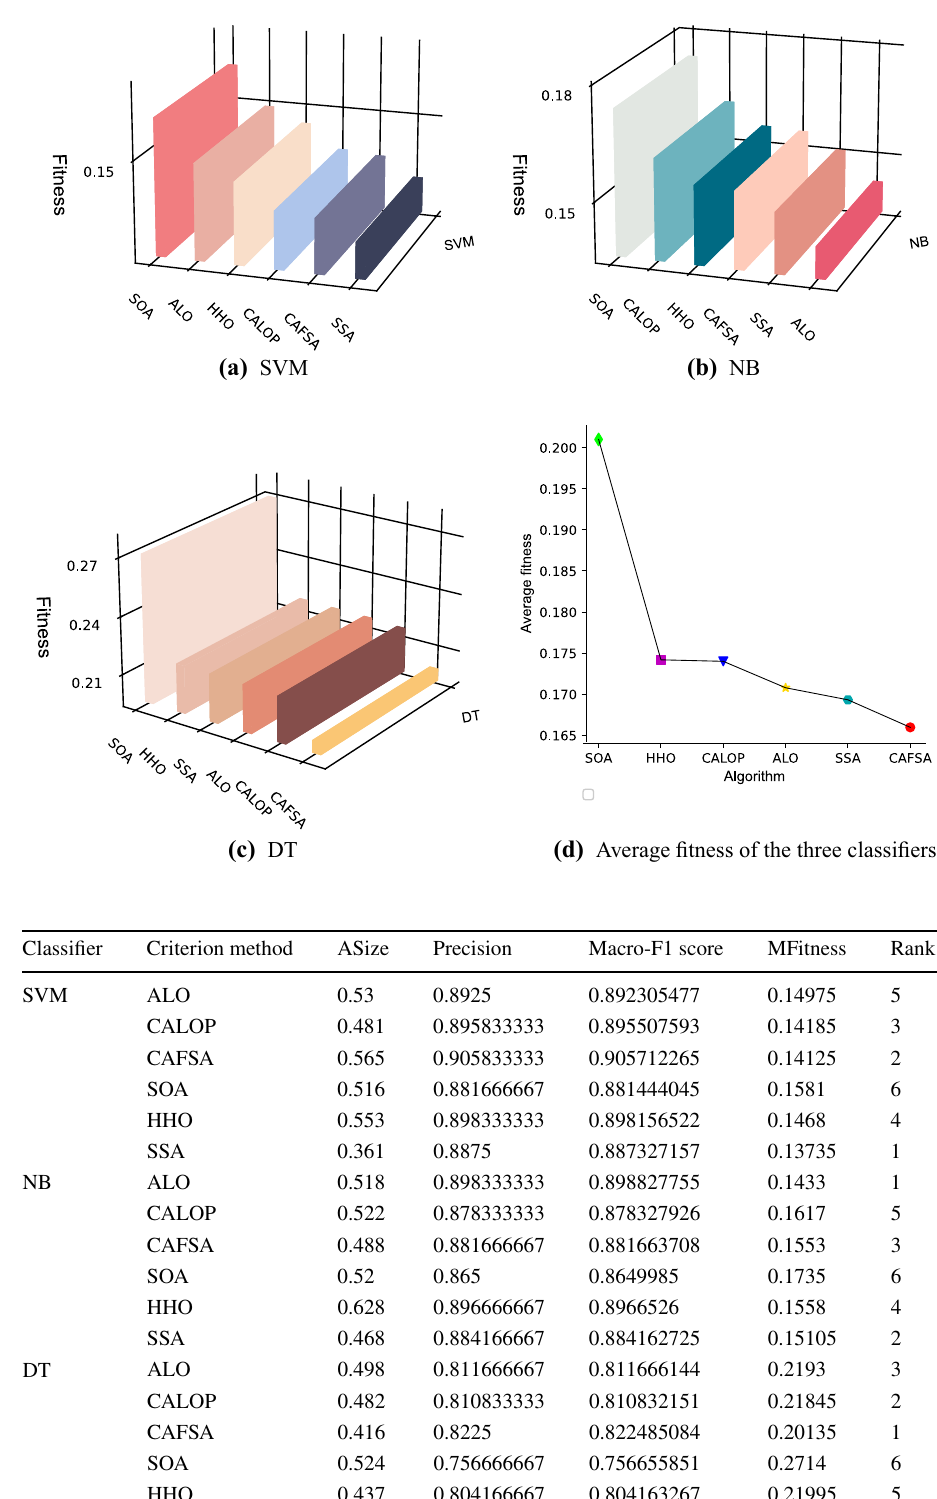
Fig. 17 Comparison of different feature selection algorithms on ChnSenticorp_NoteBook dataset